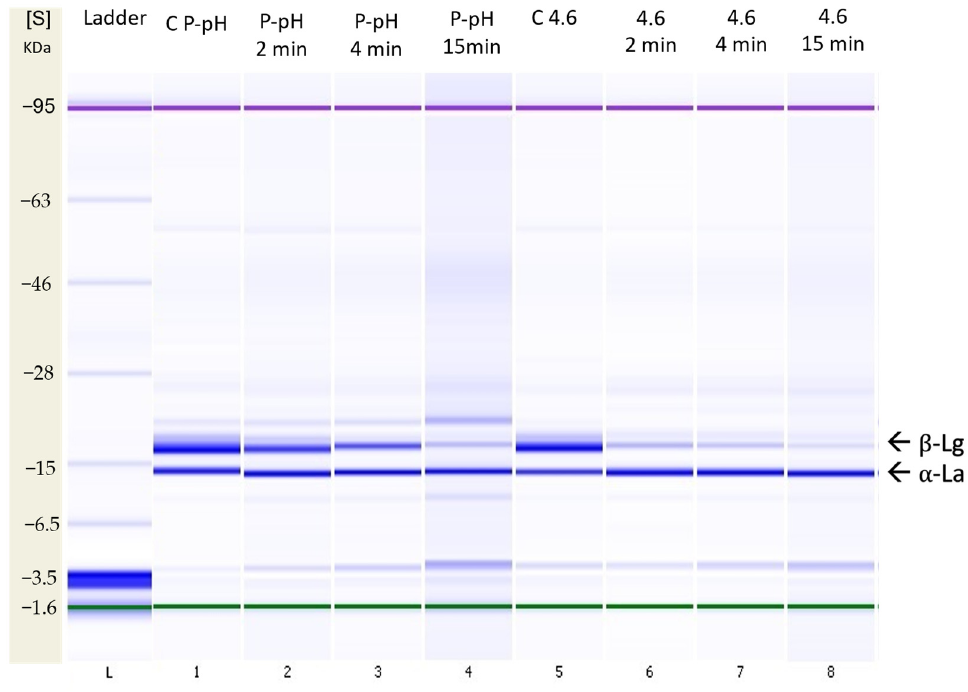
Figure 7. Non-reducing SDS-PAGE for control (C) and high-pressure (600 MPa) treated samples (2, 4 and 15 min) for native whey concentrate supernatant (NWC sup ) at physiological pH (P-pH) and